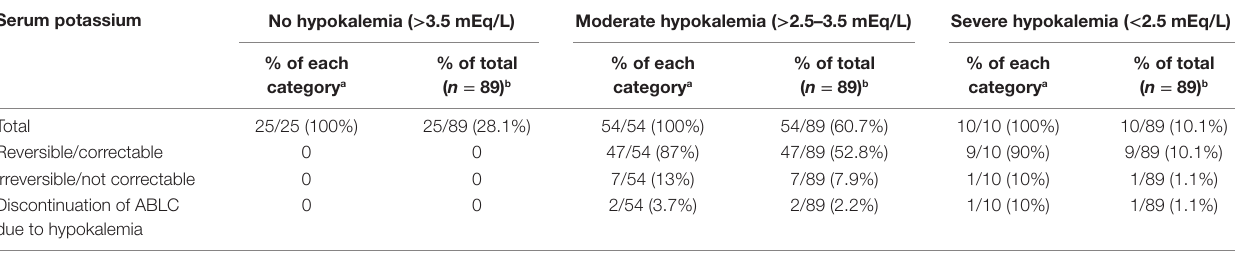
TaBle 4 | hypokalemia due to amphotericin B lipid complex (aBlc). serum